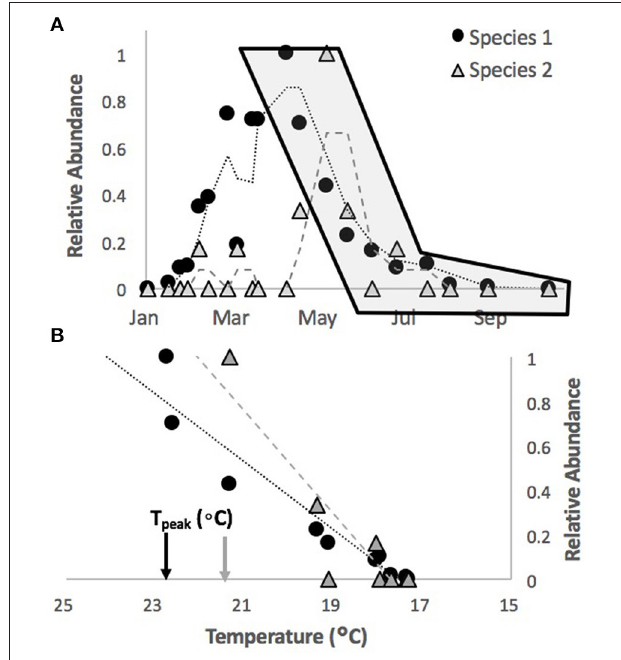
FIGURE 1 | Illustration on methodology for extracting abundance-temperature relationships. From normalized abundance series over time ( A , illustrated for two random species here) data are extracted for the region of decline, starting with normalized relative abundance value of one (the point in the gray shaded area of A ). For each survey in this period the relative abundance on that survey is plotted against the temperature between that survey and the previous (B) . The best fit line to this data (dashed line in B ) is used to estimate the slope and temperature at which relative abundance was 1.0 (Tpeak, identified on the X-axis for each